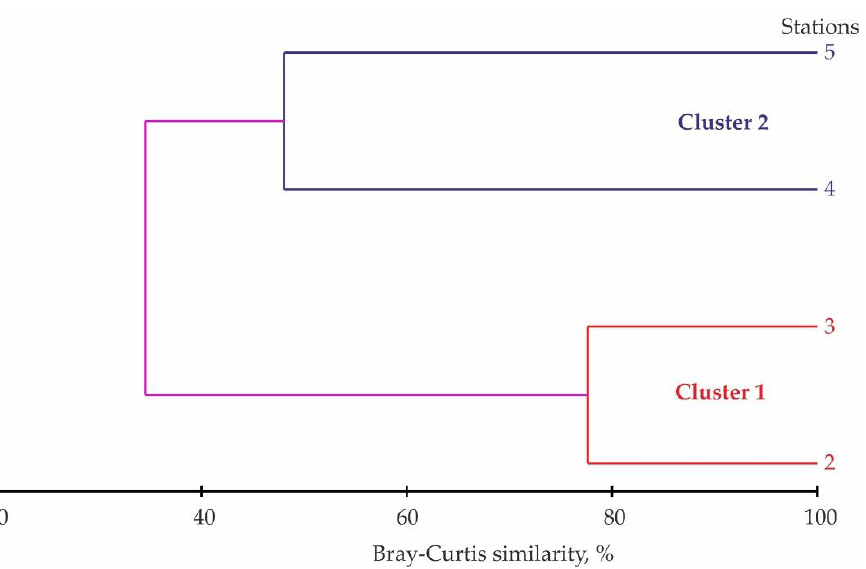
Figure 3. The results of cluster analyses (group-average method) based on the square-root trans- formed abundance of zooplankton in Lake Kulonga in March 2016.